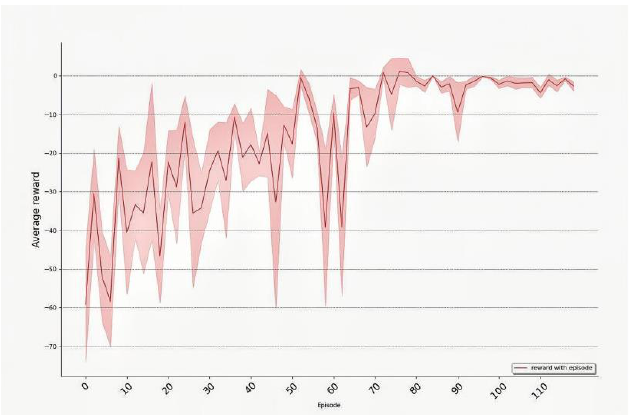
Figure 13. The change in average reward of the track planning module with the number of training wheels.